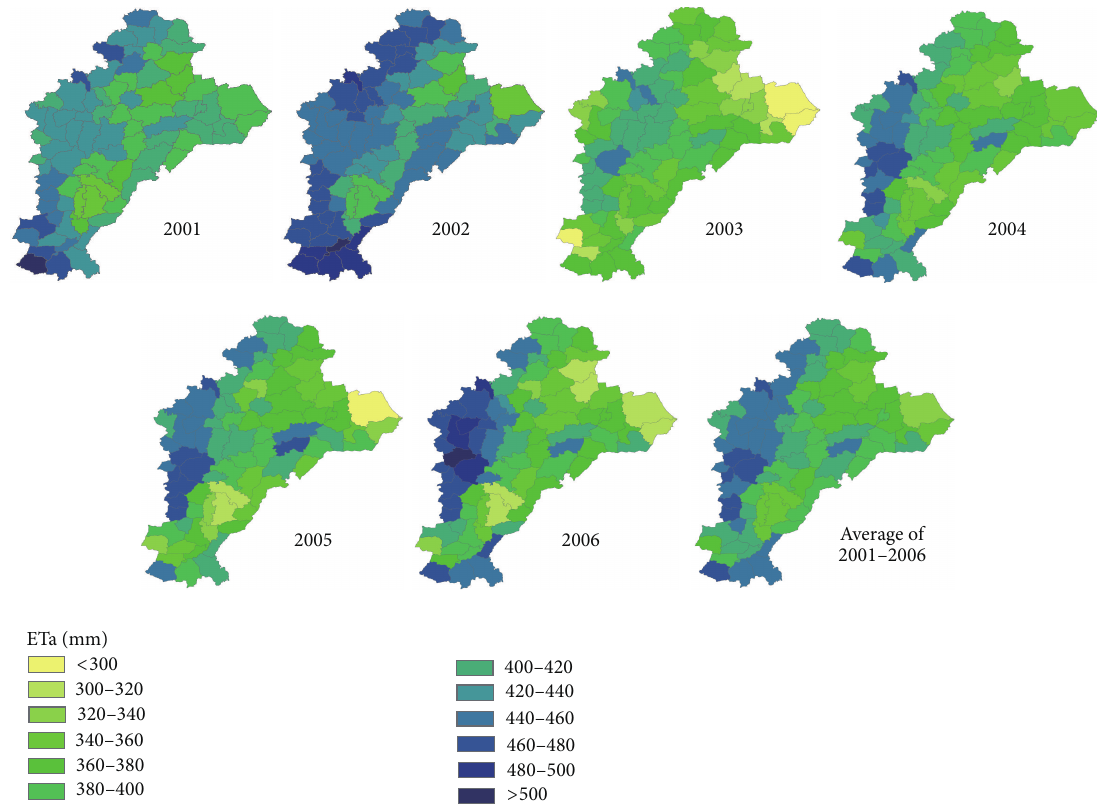
Figure 5: Winter wheat’s ETa in Hebei Plain from 2001 to 2006.